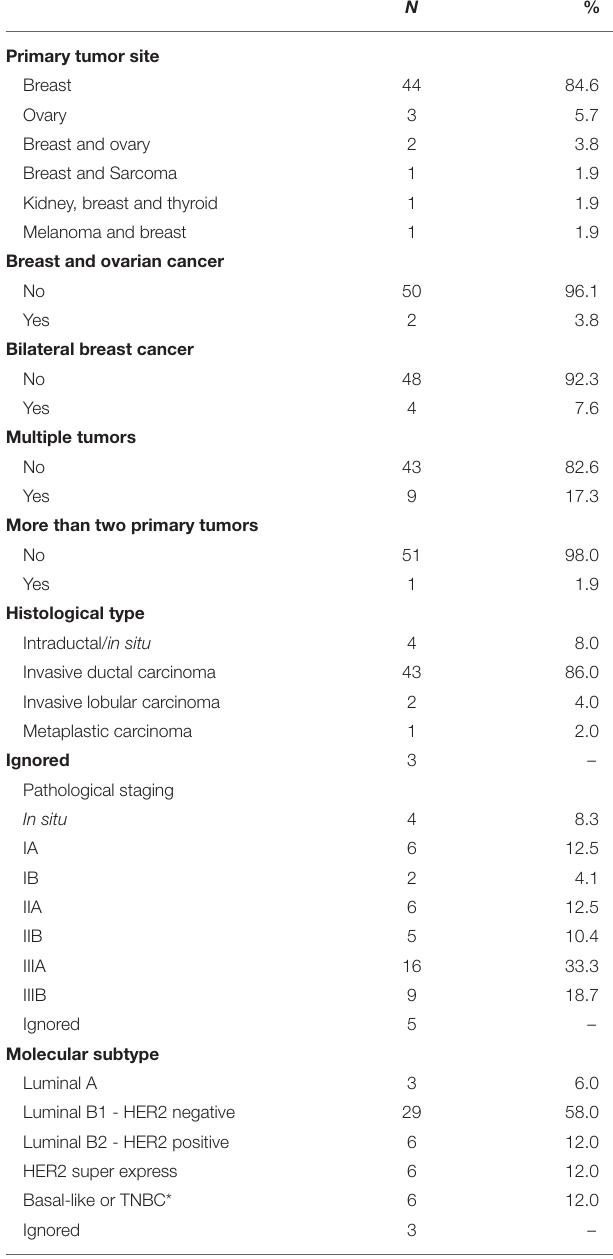
TABLE 1 | Clinicopathological characteristics of the 52 patients included in the